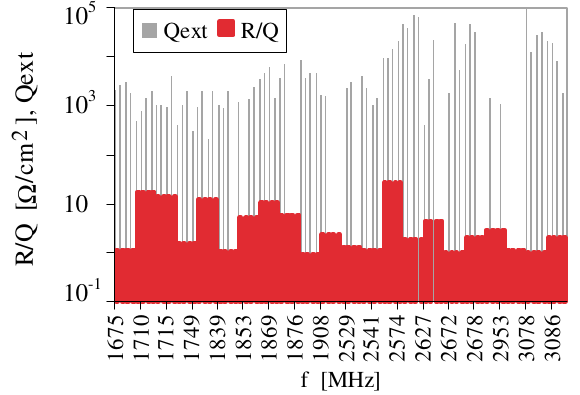
FIG. 13. (Color) Damping of dipoles with (cid:7) R=Q (cid:10) (cid:12) 1 (cid:12) = cm 2 .